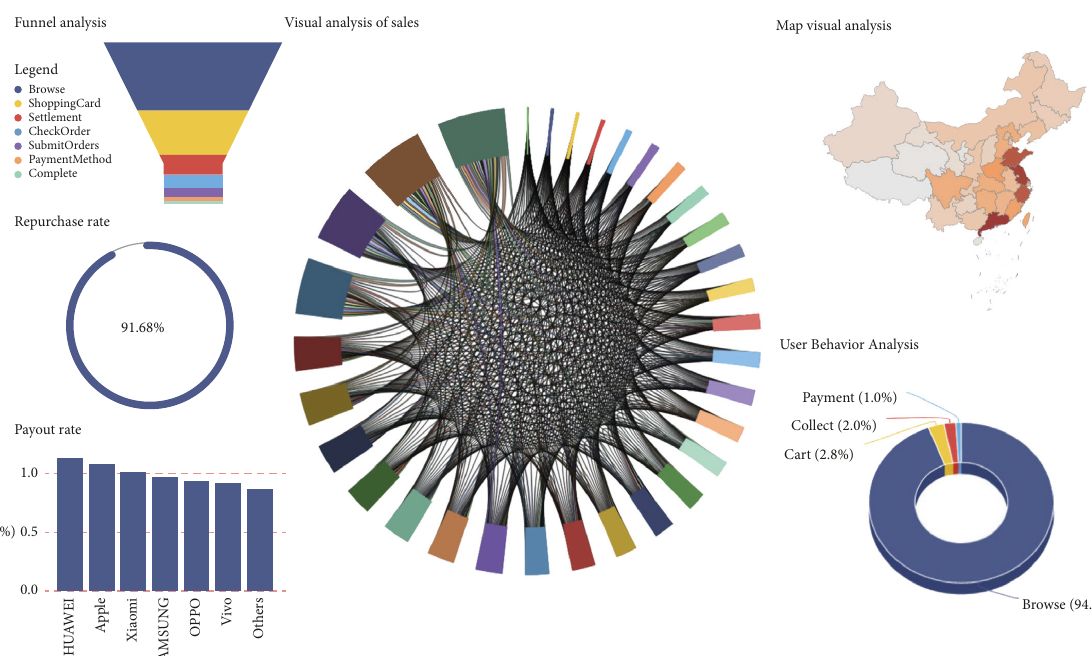
Figure 1: Overview of the proposed